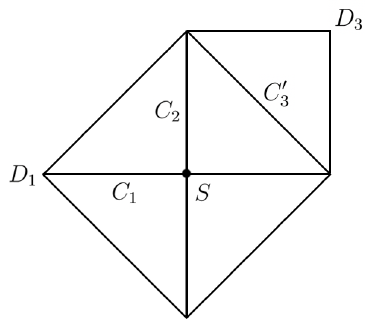
Figure 25 . The toric diagram for flopped f dP 2